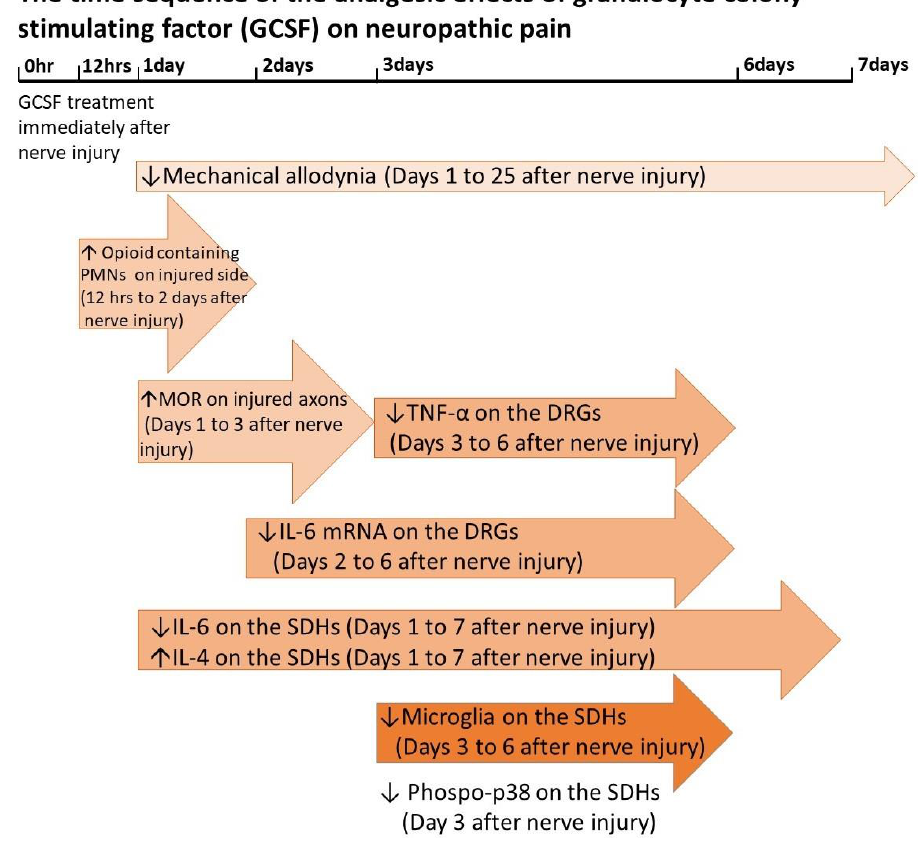
Figure 1. The time sequence of the analgesic e ff ects of granulocyte colony stimulating factor (GCSF) on neuropathic pain. Compared to vehicle-treated chronic constriction injury (CCI) rats, the sequential e ff ects of GCSF on GCSF-treated CCI rats increased opioid containing polymorphonuclear cells (PMNs) at injury site from 12 to 48 h and increased mu opioid receptor (MOR) levels on days 1–3 at the nerve ligature site after nerve injury; decreased IL-6 and TNF- α levels on days 2–6, and days 3–6, respectively, in the dorsal root ganglia (DRGs) after nerve injury; decreased IL-6 but increased IL-4 levels from days 1–7 in the spinal dorsal horns (SDHs) after nerve injury; and suppressed microglia and p-p38 activation on days 3–6 and on day 3, respectively, in the spinal dorsal horn after nerve injury [1,2]. ( ↑ : increase, ↓ : decrease).